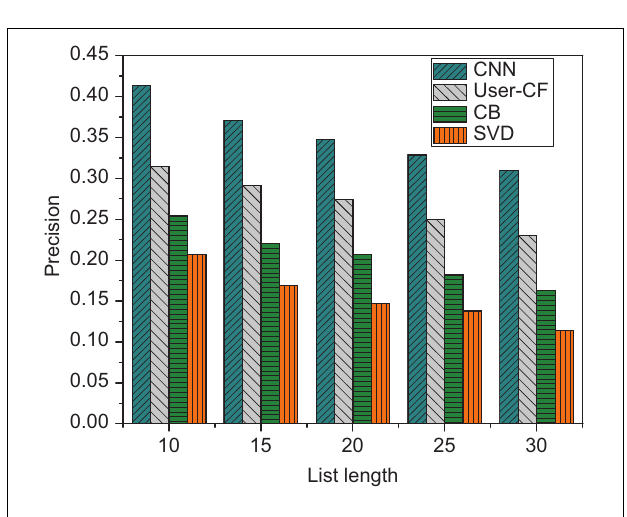
FIGURE 5 | Recommendation accuracy of different